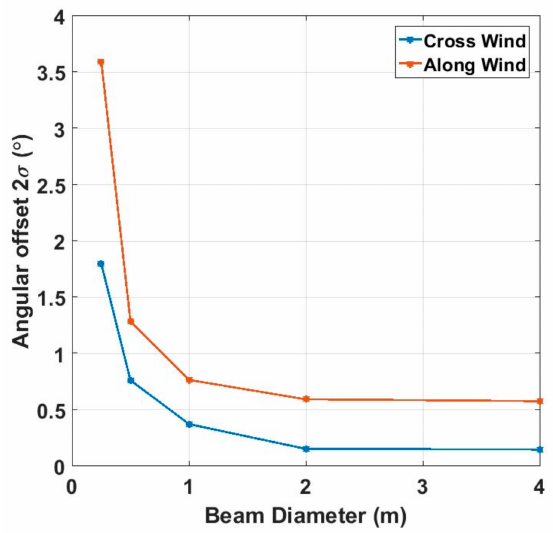
Figure 9. The refraction angle deviation change with beam diameter for averaged wind speed and incidence